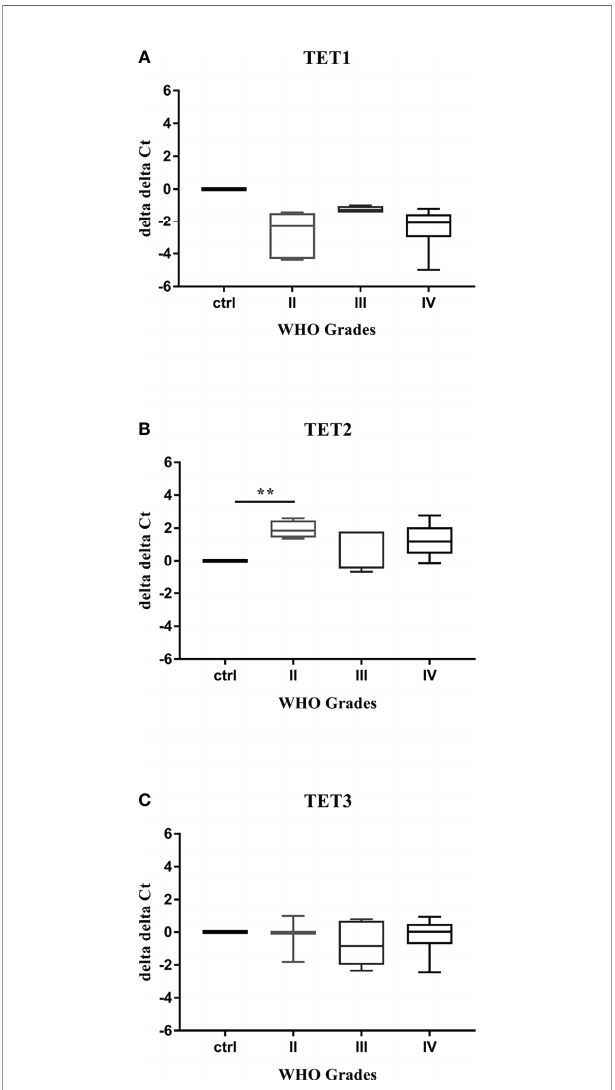
FIGURE 4 | TET transcripts pro fi ling in plasma samples. qRT – PCR analysis of TET mRNA (A – C) . Levels of TET1 (A) , TET2 (B) , and TET3 (C) transcripts were variously regulated in plasma samples obtained from patients with gliomas. Statistical analysis performed using non-parametric Kruskal-Wallis test (**p <